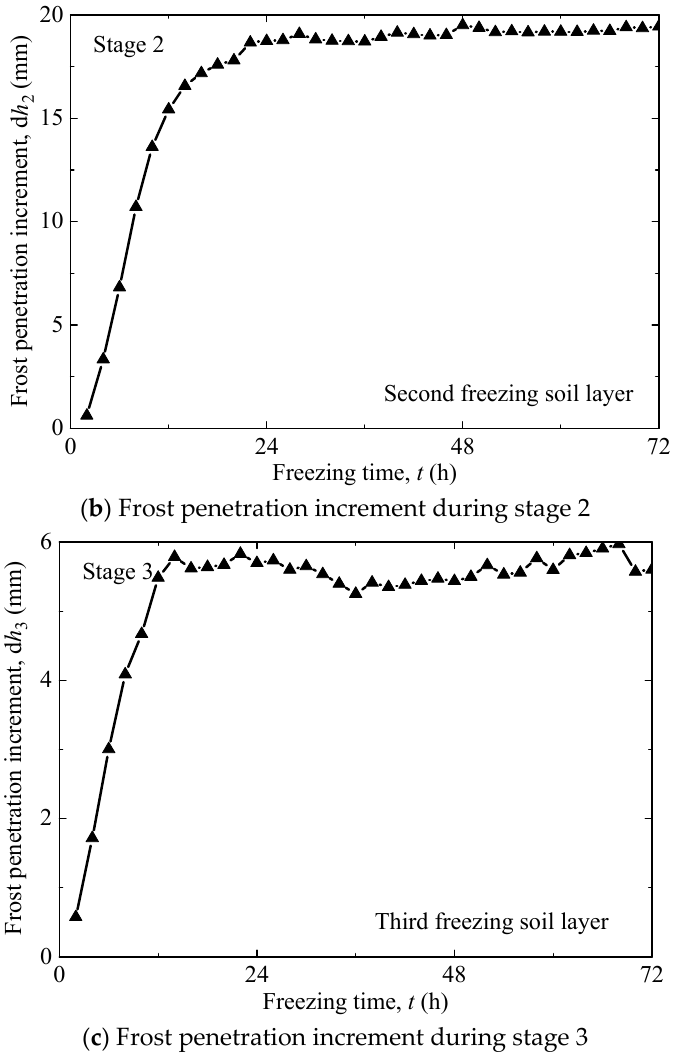
Figure 10. Frost penetration increment in freezing soil layers during ( a ) stage 1, ( b ) stage 2, and ( c ) stage 3.